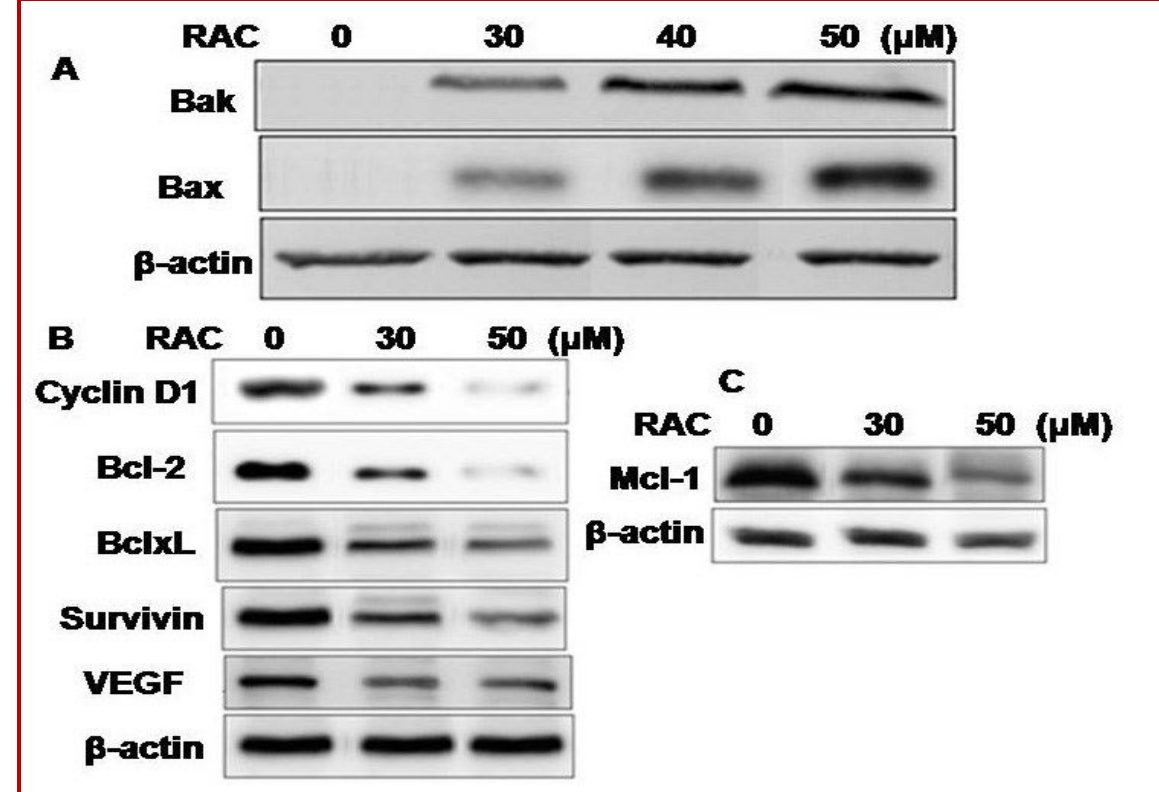
Figure 5: 2-Fluorobenzaldehyde retinoic acid conjugate promotes the expression of proapoptotic Bax and Bak proteins (A). 2- Fluorobenzaldehyde retinoic acid conjugate inhibits STAT3 regulated antiapoptotic gene, cyclin D1, Bcl-2, Bcl-XL, survivin, and VEGF (B). 2-Fluorobenzaldehyde retinoic acid conjugate inhibits the expression of Mcl-1 protein (C)